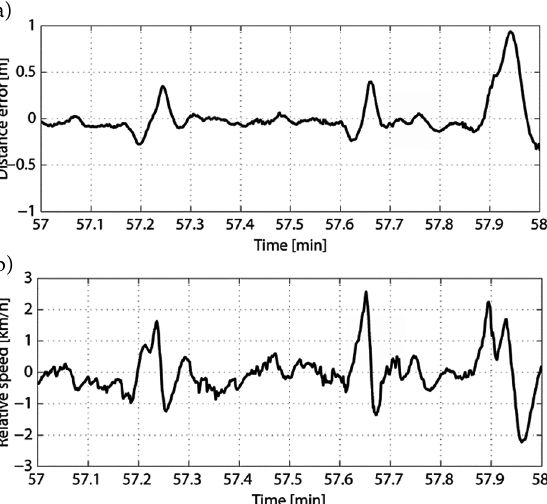
Fig. 14. Evolution of the input variables for lateral control: